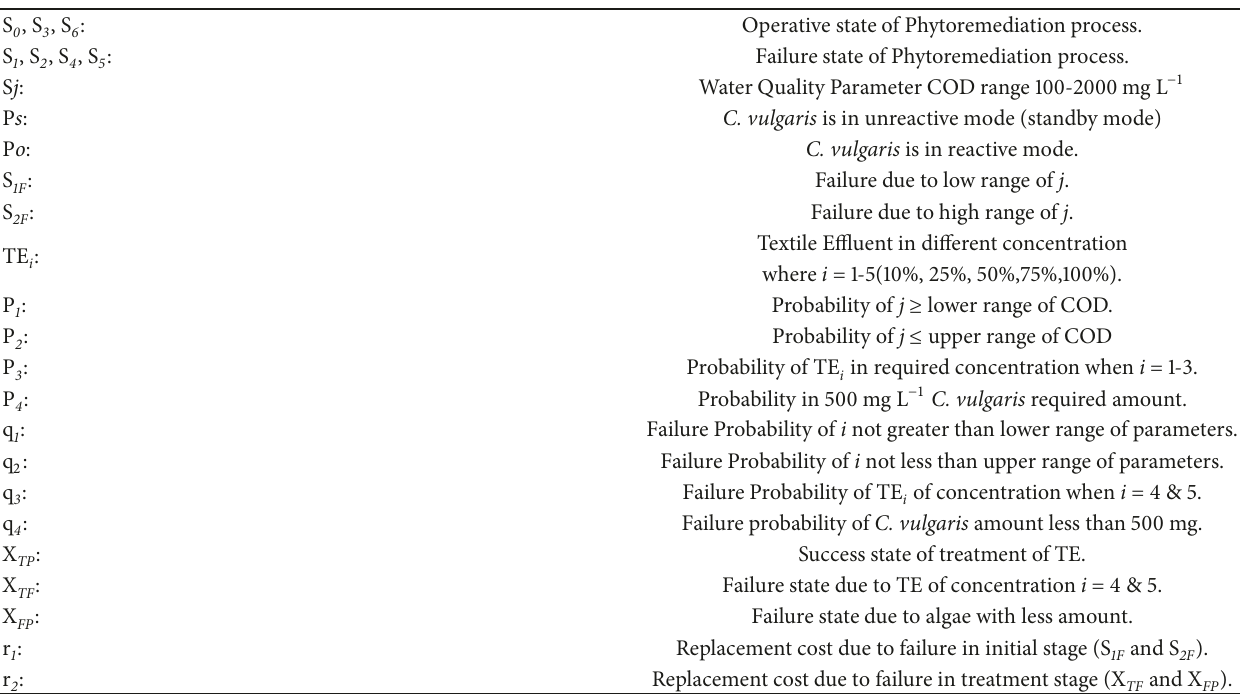
Table 4: Nomenclature for reliability mathematical